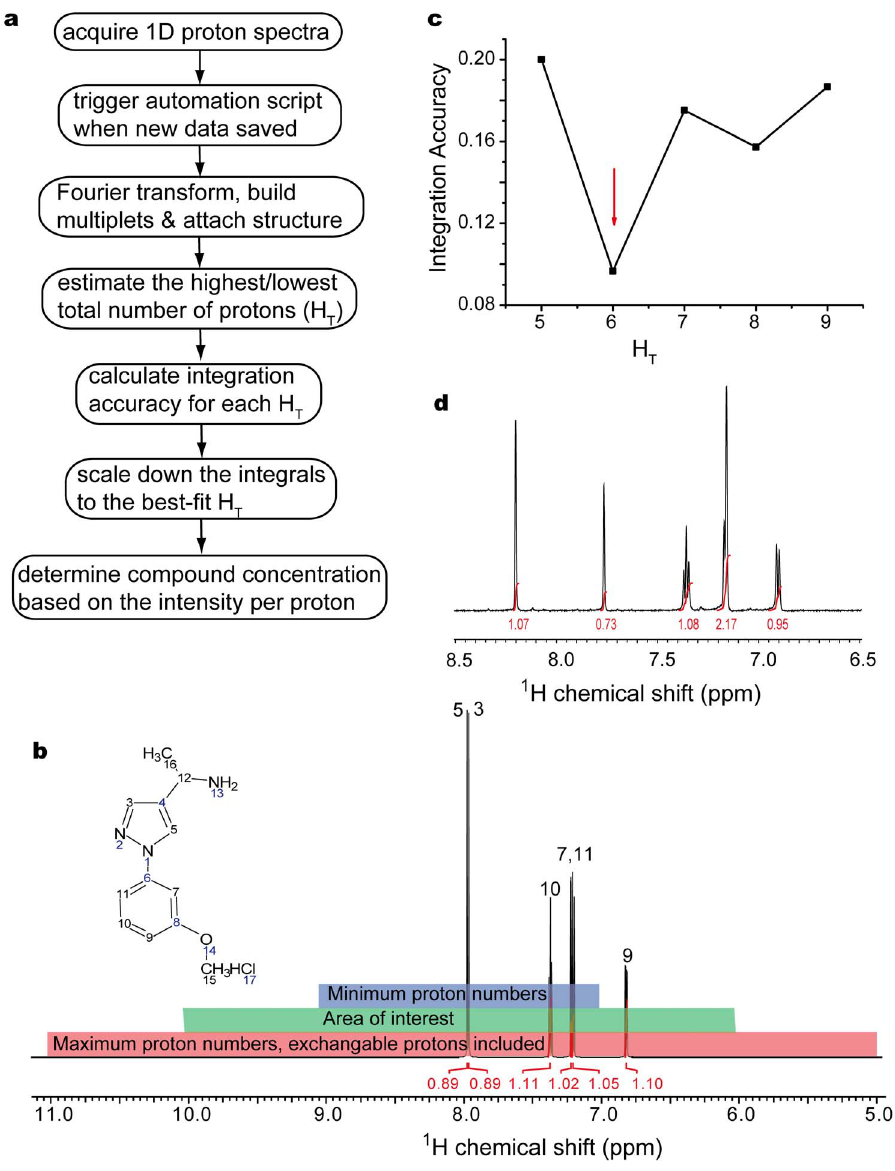
Figure 2. Determination of the aqueous concentration of fragments by automated quantitative NMR. a) The flow path of the processing and automated concentration measurement from 1D proton spectra. b) The predicted proton spectrum of a typical fragment compound with the area of interest in green, where the minimum (maximum) of H T was the number of protons counted in the purple and red area, respectively. The exchangeable protons are included only in the estimation of maximum proton numbers. c) The integration accuracy for an experimental spectrum correlates with the total number of protons (H T ) within the area of interest, where the arrow indicated the best-fit value for H T . d) The experimental spectrum with the total integrals within AOI given by the best-fit H T